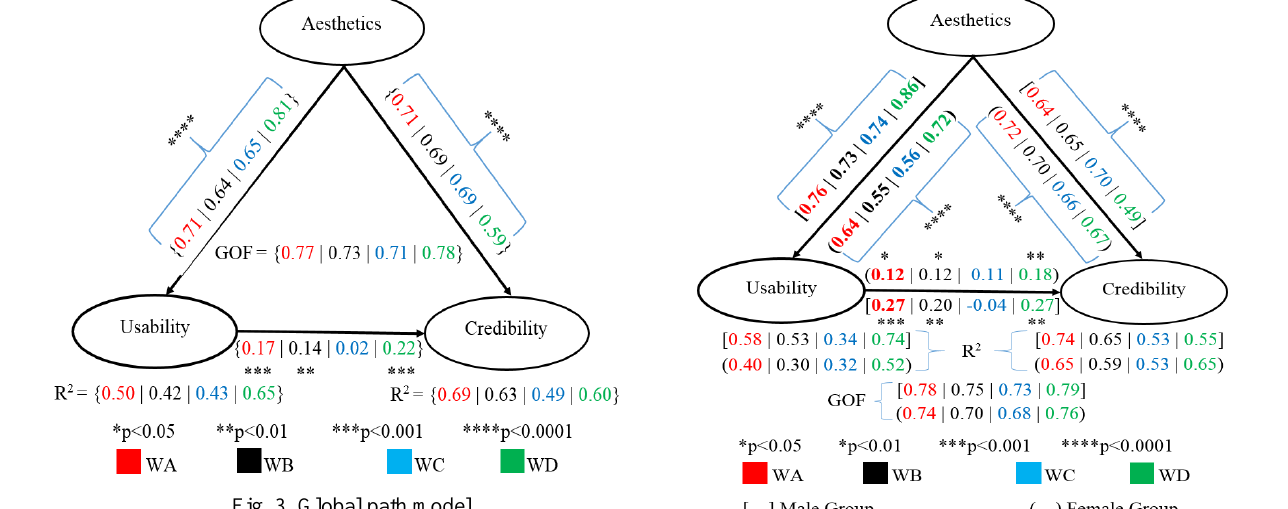
Fig. 3. Global path model.